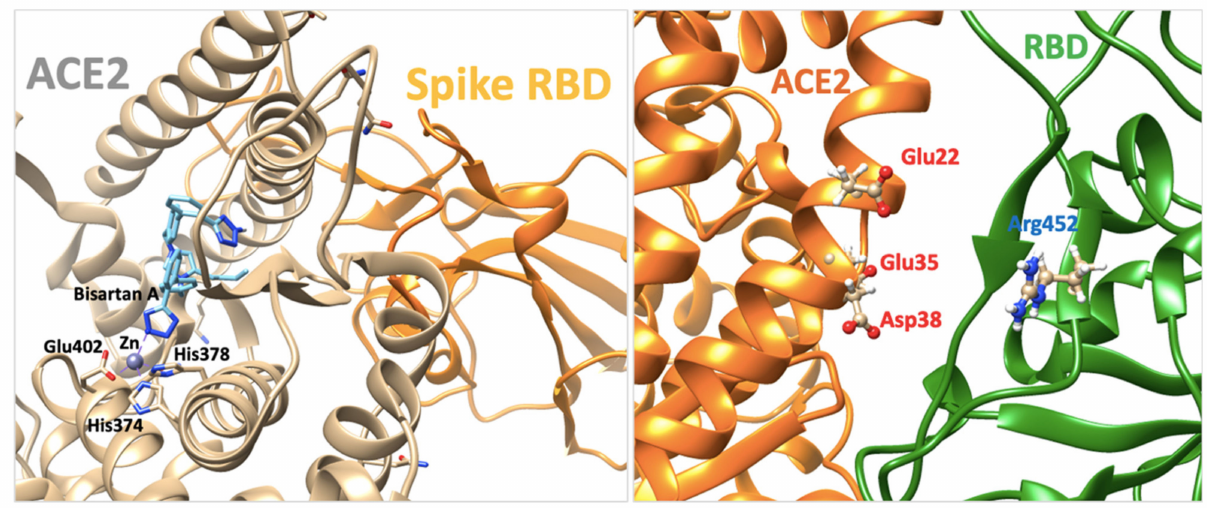
Figure 16. Left : Close view of bisartan A bound to ACE2, close to the Zn-binding catalytic site of the receptor. Right : R452 in S-protein RBD close to the nearest negatively charged residues (E22, D38, and E35) of ACE2